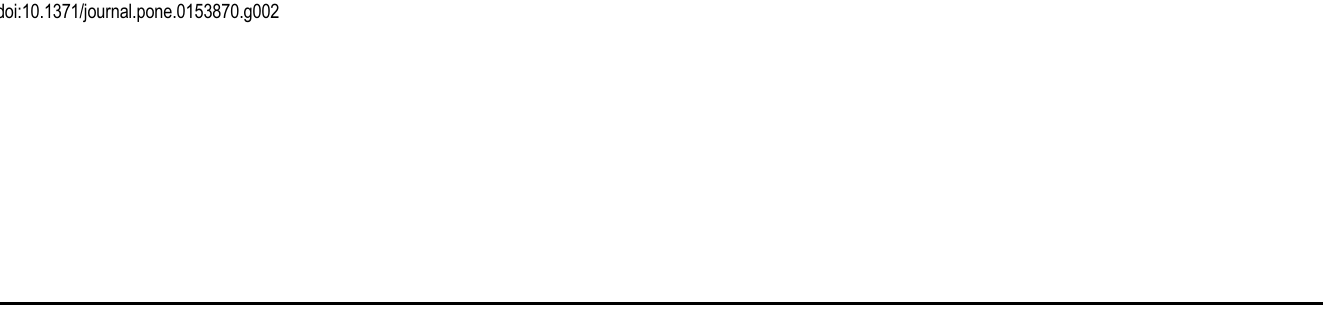
Fig 2. Mutual authentication and key agreement of our